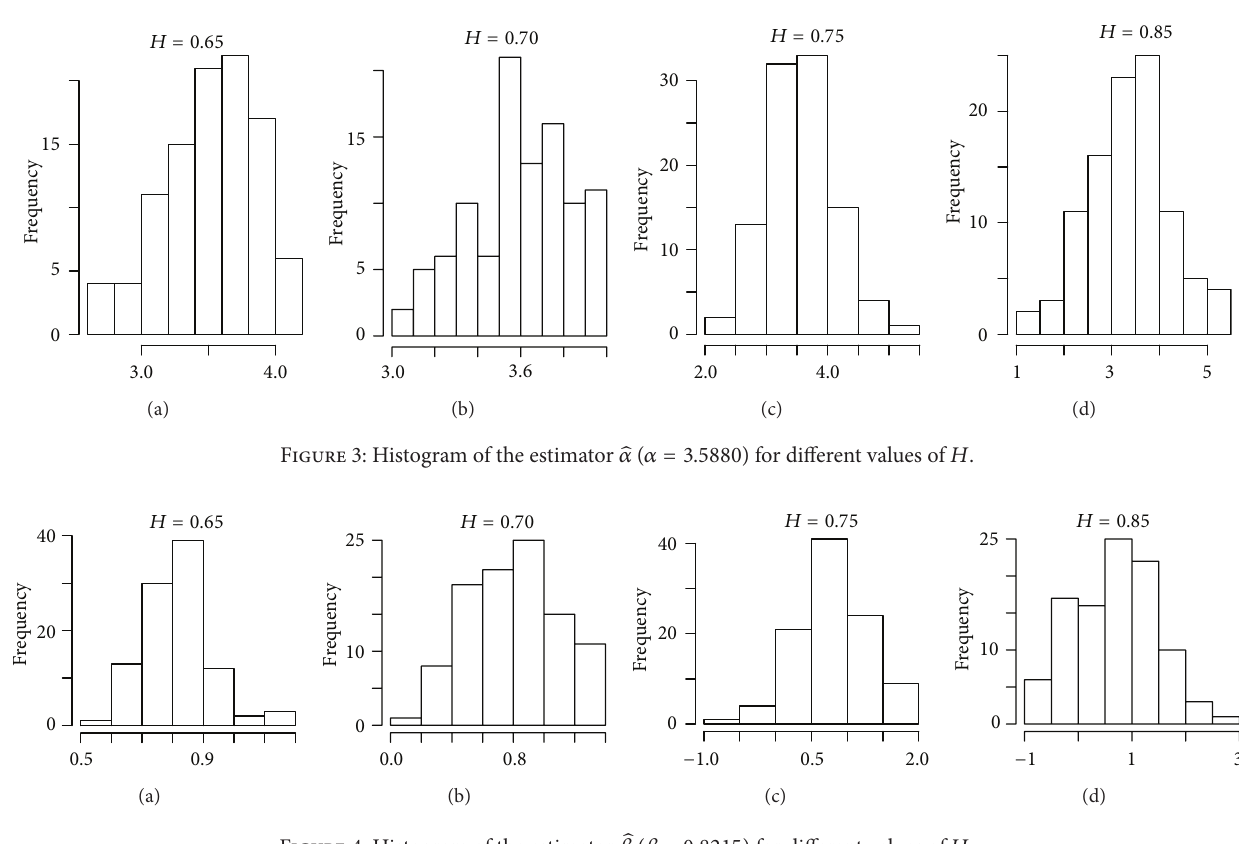
Figure 4: Histogram of the estimator